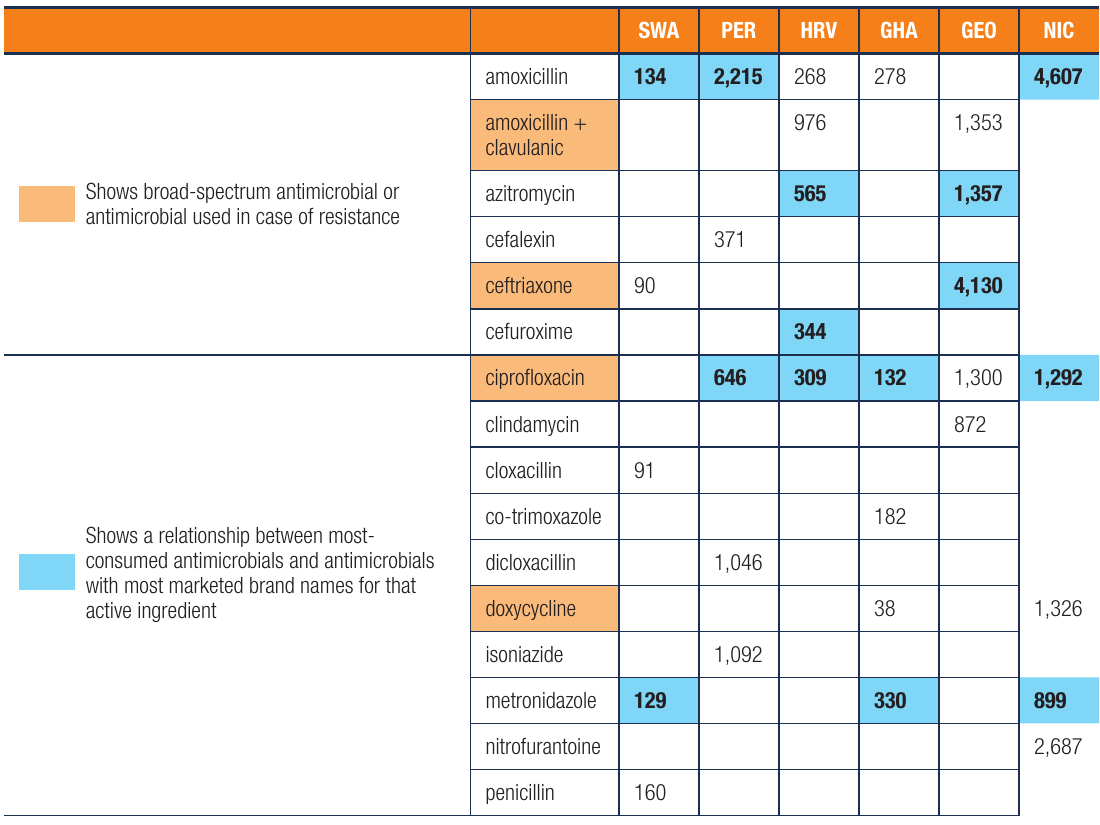
FIGURE A9.4. Top Five Antimicrobials Consumed (Units/1,000 Population; Except in Georgia, Where Data Are in Defined Daily Doses/1,000 Population)